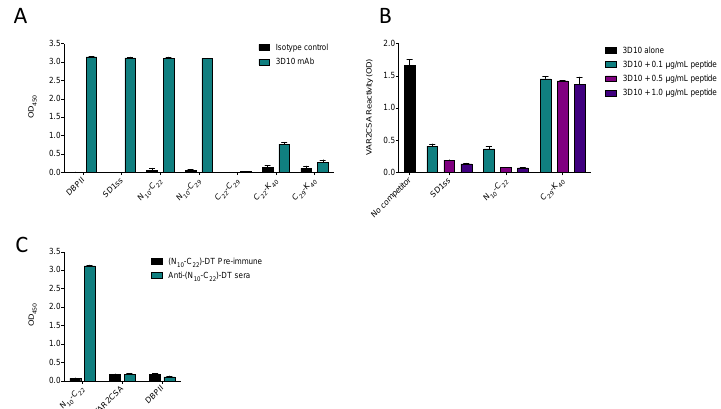
Figure 2. N 10 -C 22 is the minimal epitope for 3D10 recognition of DBPII and VAR2CSA but does not elicit cross-reactive antibodies in mice. ( A ) Synthetic peptides spanning the SD1 region of DBPII were screened with 3D10 by ELISA. Recombinant DBPII protein was included as a positive control. ( B ) 3D10 was incubated alone (black bar) or with increasing concentrations of SD1ss, N 10 -C 22 , or C 29 -K 40 , then added to wells coated with recombinant full-length VAR2CSA. ( C ) Pooled sera from mice (n = 5) before and after immunization with (N 10 -C 22 )-DT were tested against N 10 -C 22 , VAR2CSA, and DBPII by ELISA. Data are mean ± standard deviation